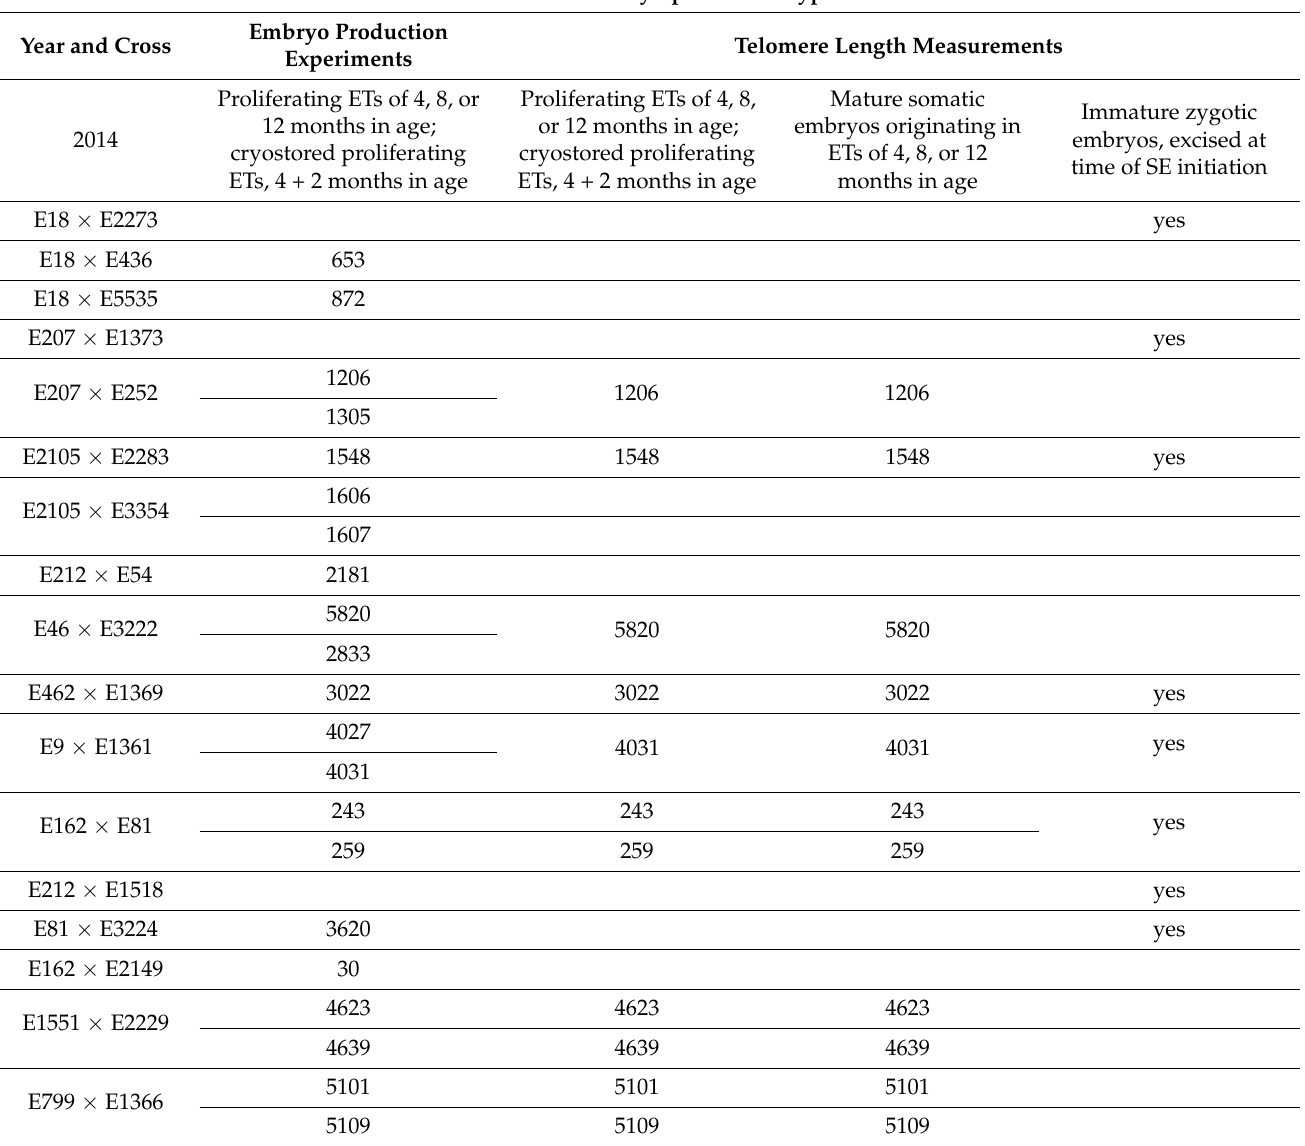
Table A2. Norway spruce materials used in somatic embryogenesis and telomere length studies: Controlled crosses from which the embryogenic tissues (ETs) were derived, and genotypes used to examine embryo production capacity and length of telomeric repeats in ETs of varying age, prior to and following